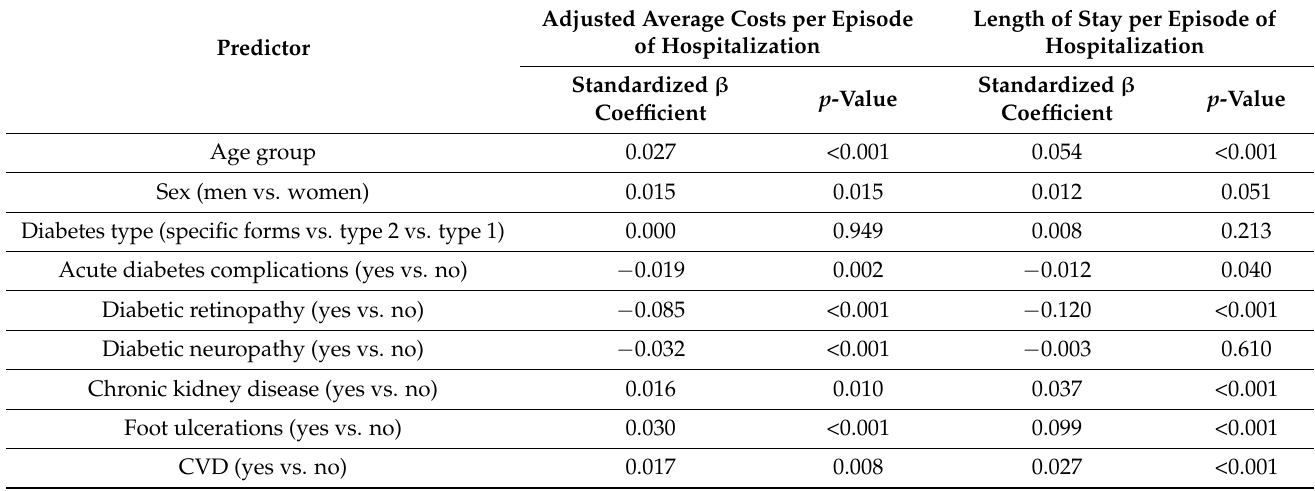
Table 4. Predictors of CPI-adjusted costs and length of stay per episode of